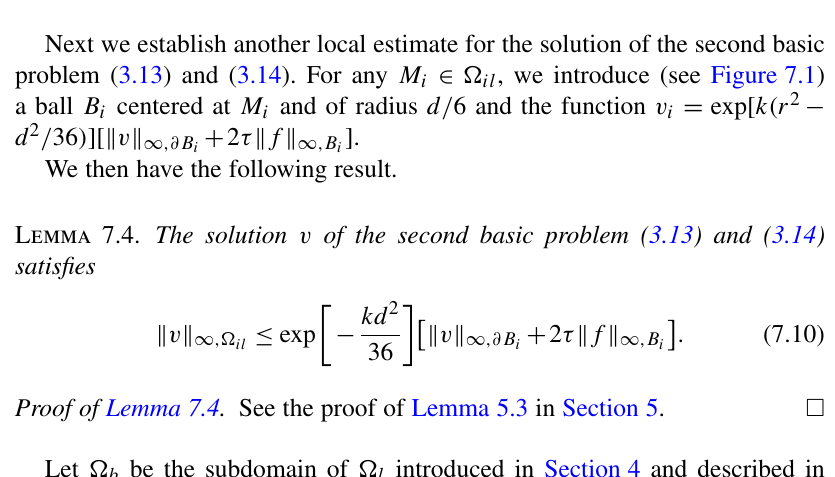
Figure 7.1. The next result states an H 1 global estimate of the solution of the second basic